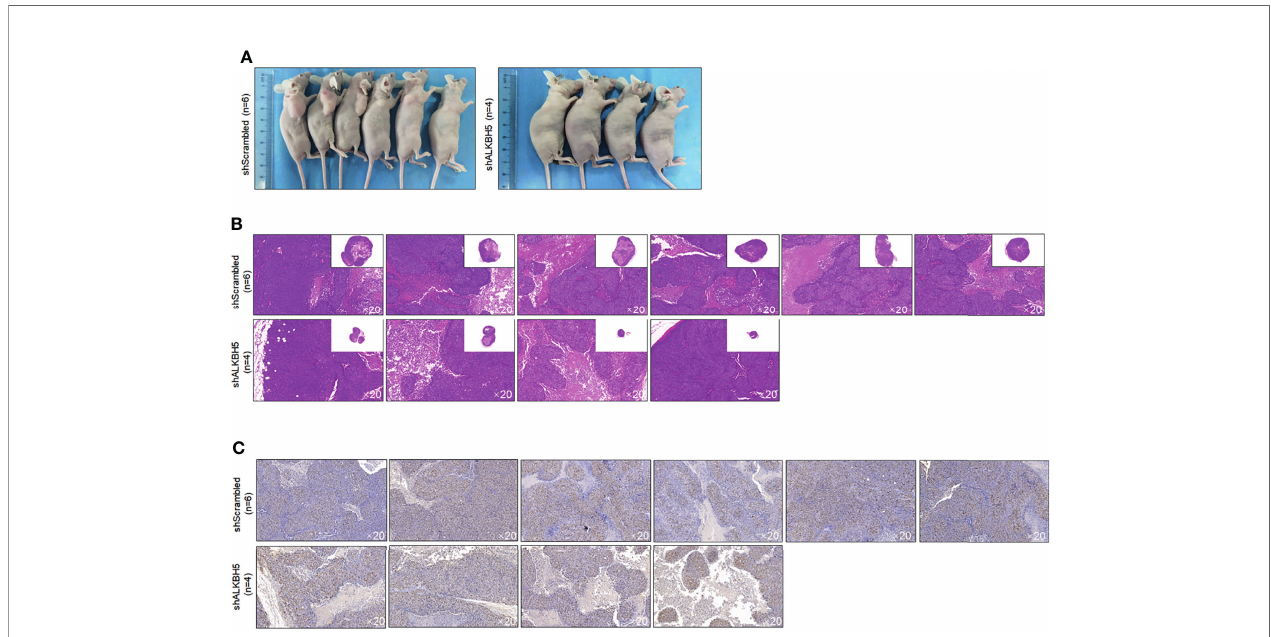
FIGURE 9 | ALKBH5 knockdown decreased tumor formation in nude mice. (A) Volume of CSCs formed tumors in nude mice after seeding 5 × 10 5 cells. Tumor formation was morphologically identi fi ed by H&E staining (B) , and cell proliferation marker Ki67 (C) were further